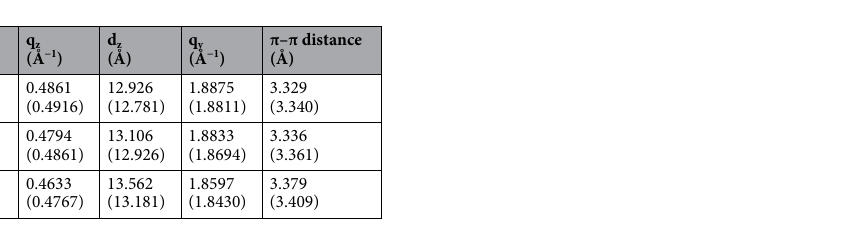
Table 1. Structural parameters of the PEDOT:Tos thin films. *The data present in the parentheses are those under nitrogen flow pressure.